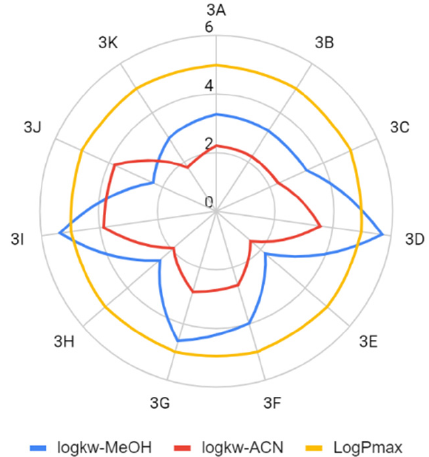
Figure 4. Comparison of the experimental lipophilicity values of the compounds tested (LogPmax— maximum logP value that satisfies Lipi ń ski’s rule).